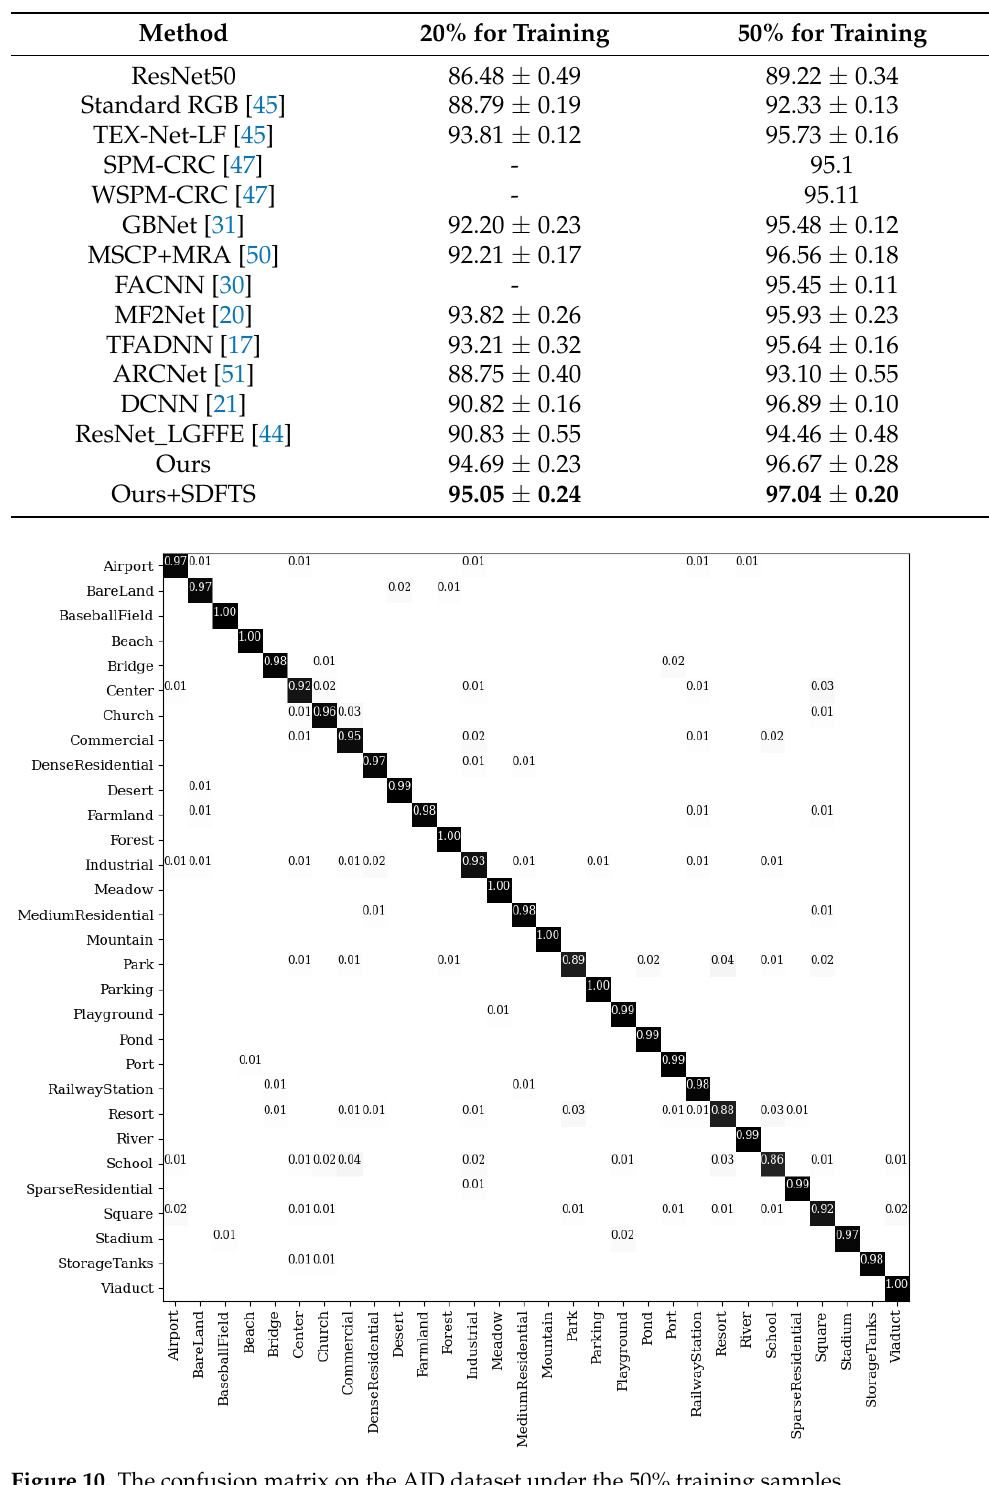
Table 7. The performance comparison for the AID dataset. SDFTS represents the stochastic decision- level fusion training strategy. The bold values denote the best performance of different training ratio.